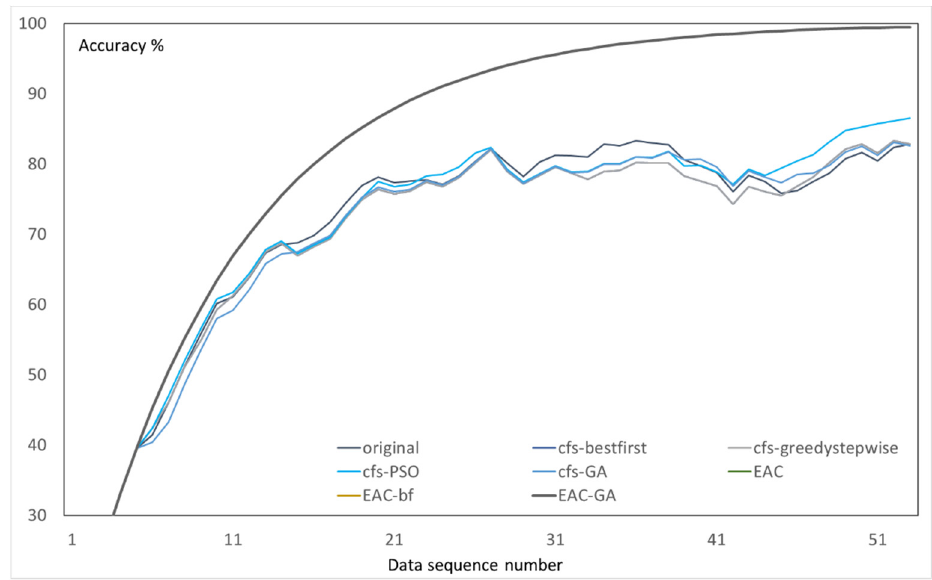
Figure 7. Comparative graph of accuracy of the Hoeffding tree model coupled with seven prepro- cessing algorithms.